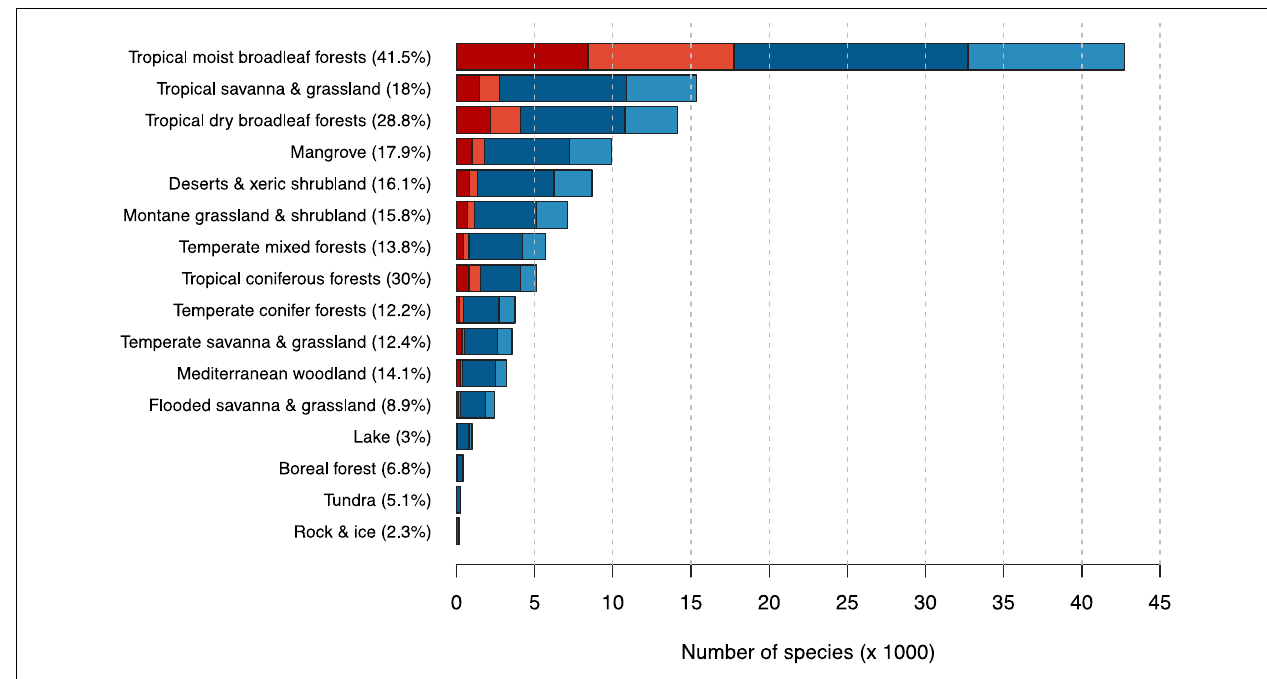
FIGURE 3 | Number of possibly threatened (red) and not threatened (blue) tree species in different biomes after Olson et al. (2001). Darker shades indicate species count from the IUCN RL, while lighter shades indicate species counts from our automated assessment. Percentages next to biome names indicate the percentage of threatened tree species in this biome. Biome names are simplified for better